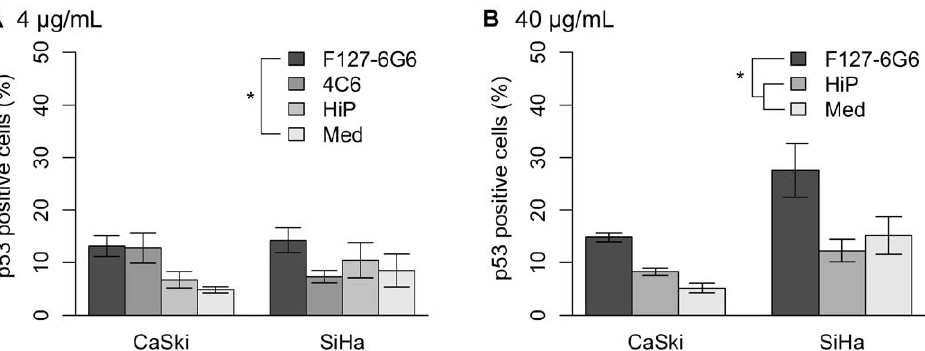
Figure 5. p53 expression following chemical transfection with E6 antibodies. (A) p53 positive cells (%) 48 hours following chemical transfection with 4 m g/mL of HPV16 E6 antibodies. Transfection of the F127-6G6 antibody significantly increased the number of p53 positive SiHa and CaSki cells compared to cells receiving medium alone (Med) ( P= 0.036, n= 3) but not compared to cells treated with only the HiPerFect (HiP) transfection reagent ( P . 0.05, n =3). (B) p53 positive cells (%) 48 hours following chemical transfection with 40 m g/mL of the HPV16 E6 antibody F127-6G6. Transfection of the F127-6G6 antibody significantly increased the number of p53 positive cells compared to cells treated with only the HiPerFect transfection reagent or culture medium alone ( P= 0.005, P= 0.004 respectively, n= 3 for both). SiHa had a significantly greater number of p53 positive cells than CaSki ( P= 0.002, n= 3). Statistical analysis was performed using a two-way ANOVA followed by Tukey HSD contrast tests post hoc. Error bars represent mean + / 2 SEM. ‘‘*’’ denotes